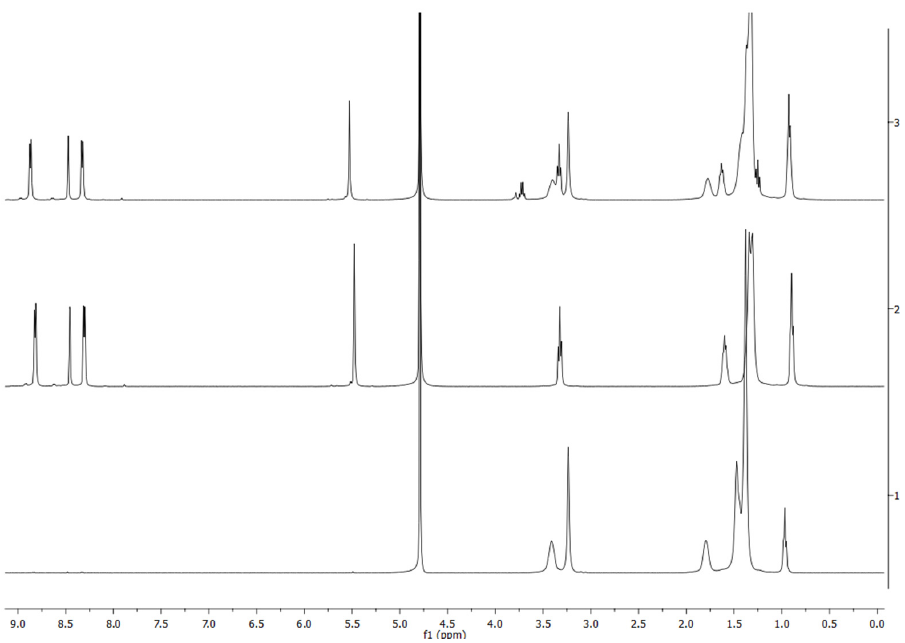
Figure 7. 1 H NMR spectra of the ( 1 ) 16-10-16, ( 2 ) IL 4-PyC8 and ( 3 ) 16-10-16:4-PyC8 in D 2 O.